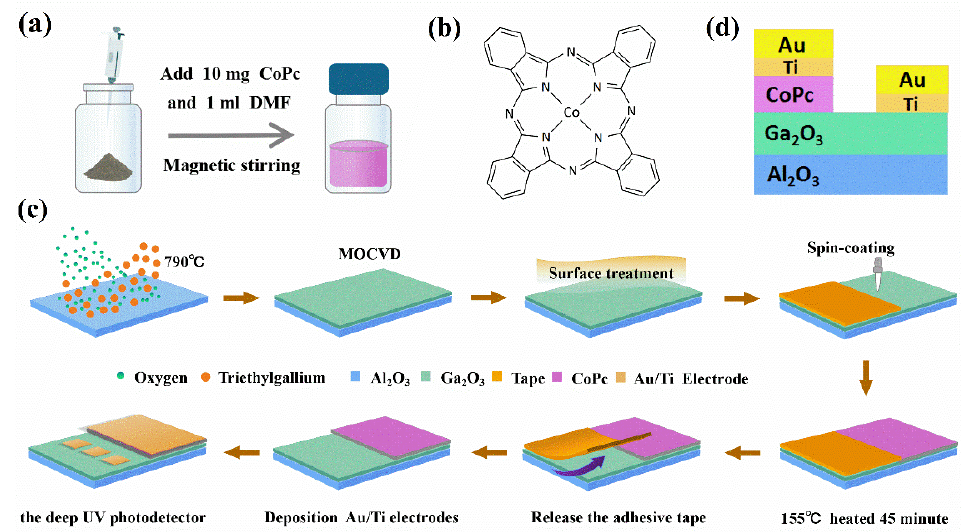
Figure 1. ( a ) Procedures for preparing the CoPc precursor solution. ( b ) Molecular structure of the semiconductor CoPc. ( c ) The fabrication of the CoPc/Ga 2 O 3 heterojunction ultraviolet photodetector. ( d ) The cross-section of fabricated devices.